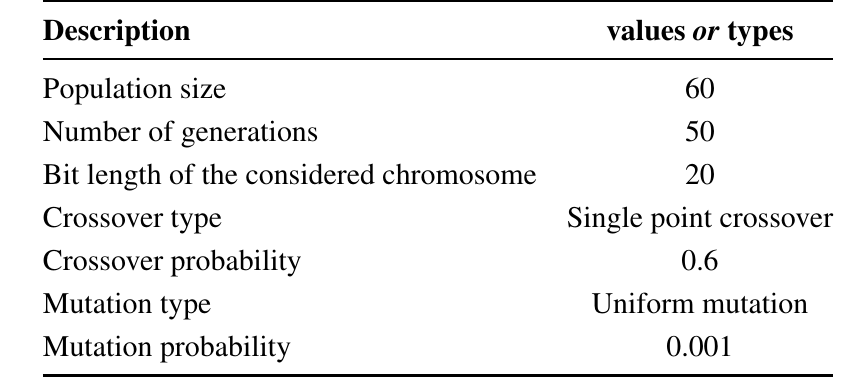
Table 2. Parameters of GA optimization.